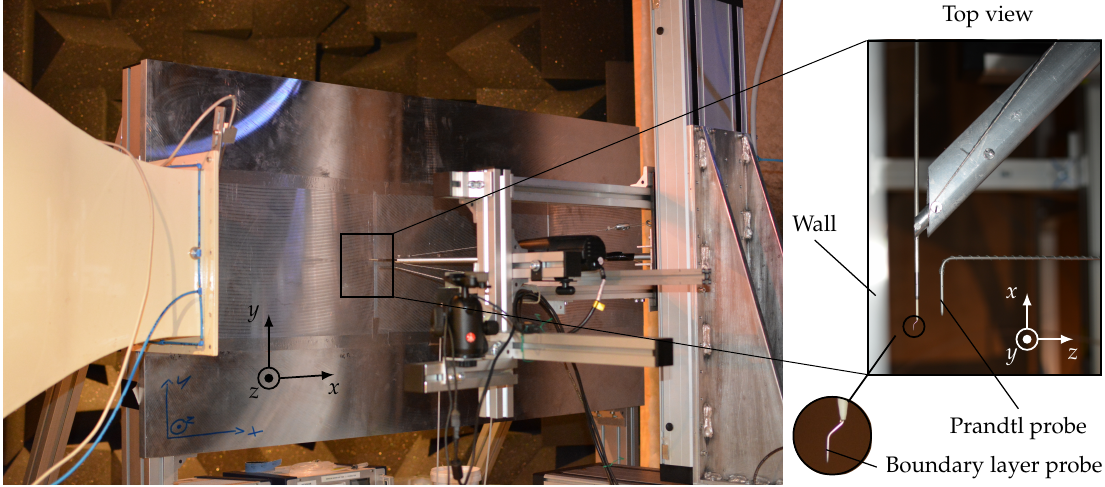
Figure 4. Measurement setup and enlargement of the boundary layer